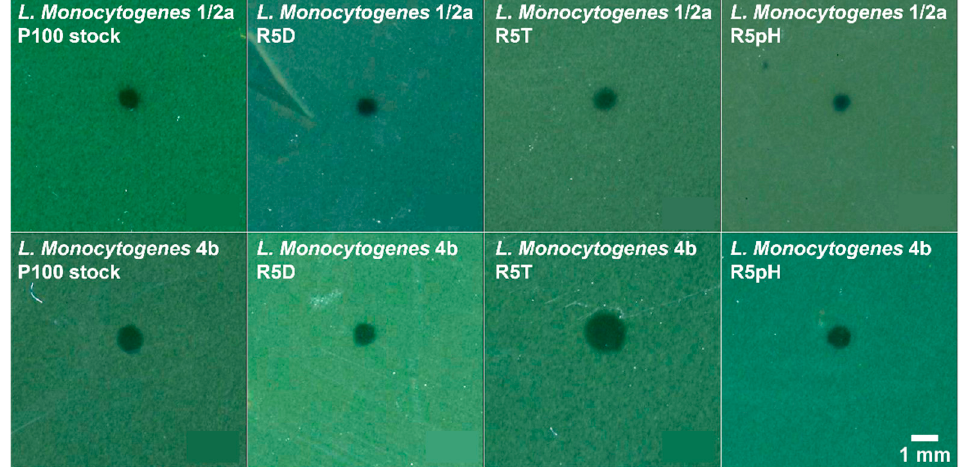
Figure 4. Plaque morphology of the different P100 bacteriophage samples infecting the L. monocyto- genes serotype 1/2a ( top row ) and 4b ( bottom row ) bacteria samples, where the plaques represent a clearing in the bacterial lawn due to bacteriophage infection. Plaques shown here are representative for each imaged soft agar overlay plate. All plaques are completely clear, round, and display defined edges. Plaque size appears to be similar for infection of a given L. monocytogenes strain. Nomenclature: R5D: P100 sample that underwent 5 cycles of desiccation selection followed by 5 propagation cycles in the absence of stress; R5T: P100 sample that underwent 5 cycles of high temperature selection followed by 5 propagation cycles in the absence of stress, R5pH: P100 sample that underwent 5 cycles of low pH selection followed by 5 propagation cycles in the absence of stress.